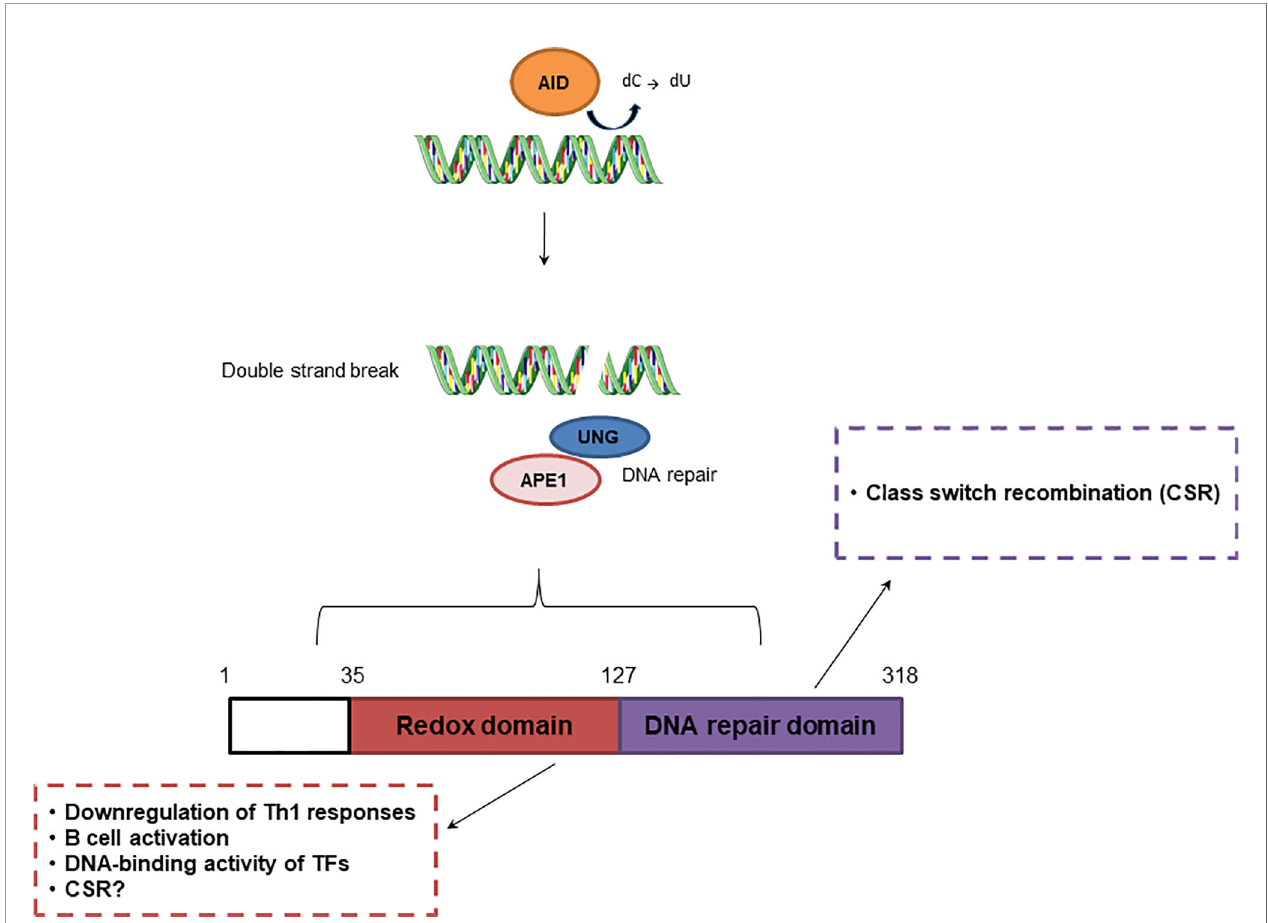
FIGURE 3 | Effect of APE1 redox and repair activities in adaptive immunity. Repair activity of APE1/Ref-1 participates in class switch recombination, while redox activity downregulates Th1 responses and regulates B cell